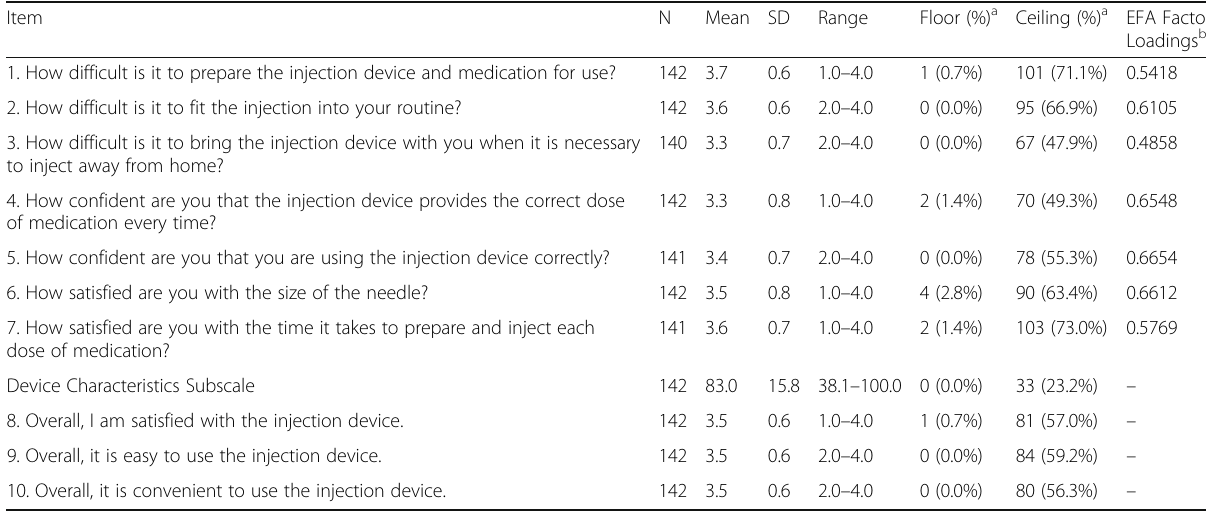
Table 2 DID-EQ: Descriptive Statistics and Exploratory Factor Analysis